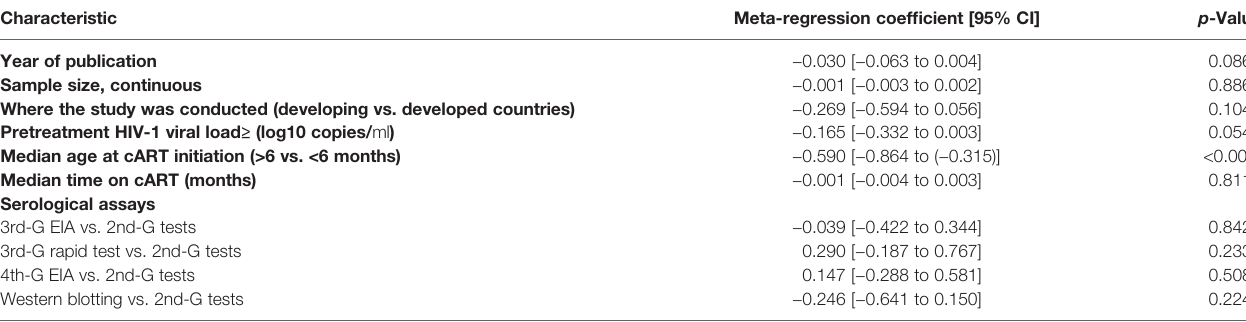
TABLE 5 | Multivariate meta-regression for the frequency of HIV-1 seronegativity in cART-treated children. Characteristic